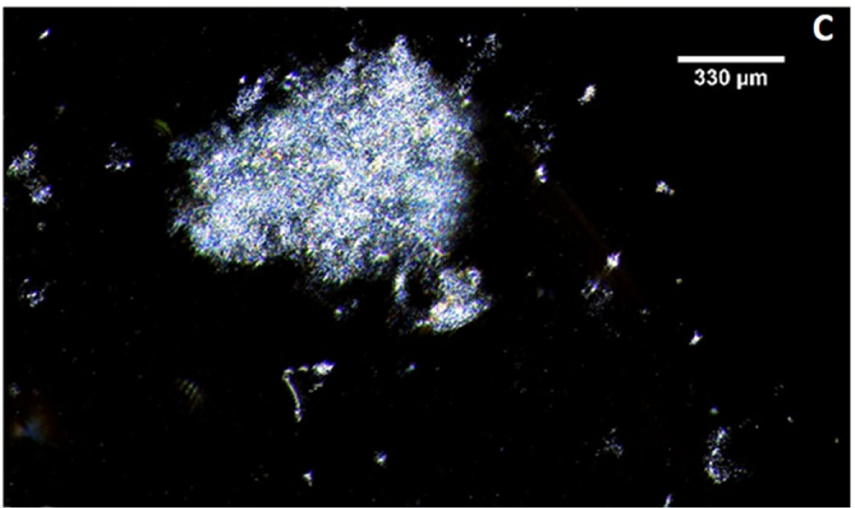
Figure 8. Pseudoalteromonas atlantica biopolymers as MGP representative grown in artificial seawater after 96 h ( A ) and after 168 h ( B ). P. atlantica particles captured with inverted microscope using 20× objective. Scale bar = 330 µm ( C ).